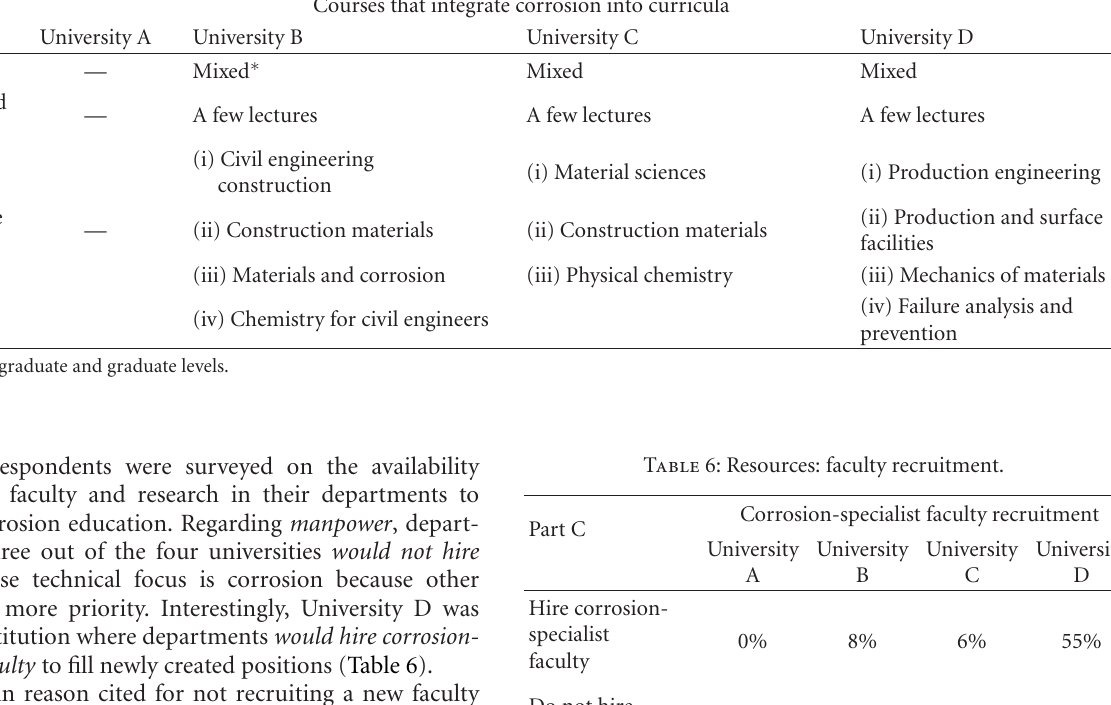
Table 5: Details on courses that integrate corrosion in curricula.